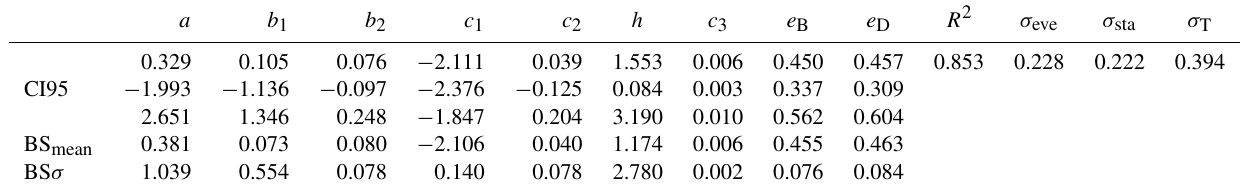
Table 3. Coefficients of Eq. (1) for the prediction of horizontal peak ground acceleration (gal) for the GMPE in this study. Magnitude is defined as M L . CI95 indicates the confidence intervals at 95% confidence level. In this table, R 2 is the determination coefficient. σ eve and σ sta are inter-event and inter-station terms of the errors, respectively. BS mean and BS σ are the mean value and the standard deviation of each coefficient, respectively, estimated by applying the bootstrap